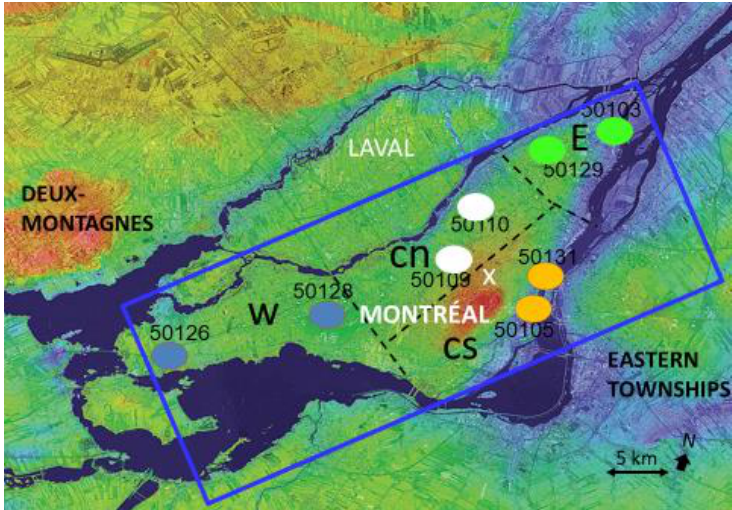
Figure 1. Location of sites for air pollution and pollen count measurement. The white X indicates the pollen measuring site at Universit é de Montr é al (UdeM). Different sectors of Montreal are shown: W (West: blue), CN (center-north: white), CS (center-south: orange) and E (east: green). Orange colors indicate higher topographic elevation. Sites 50126: Ste-Anne-de-Bellevue; 50128: Airport; 50109: D é carie/Mt. Royal; 50110: Parc Pilon; 50105: Drummond; 50131: Hochelaga; 50129: Rivi è re-des- Prairies; 50103: Parc